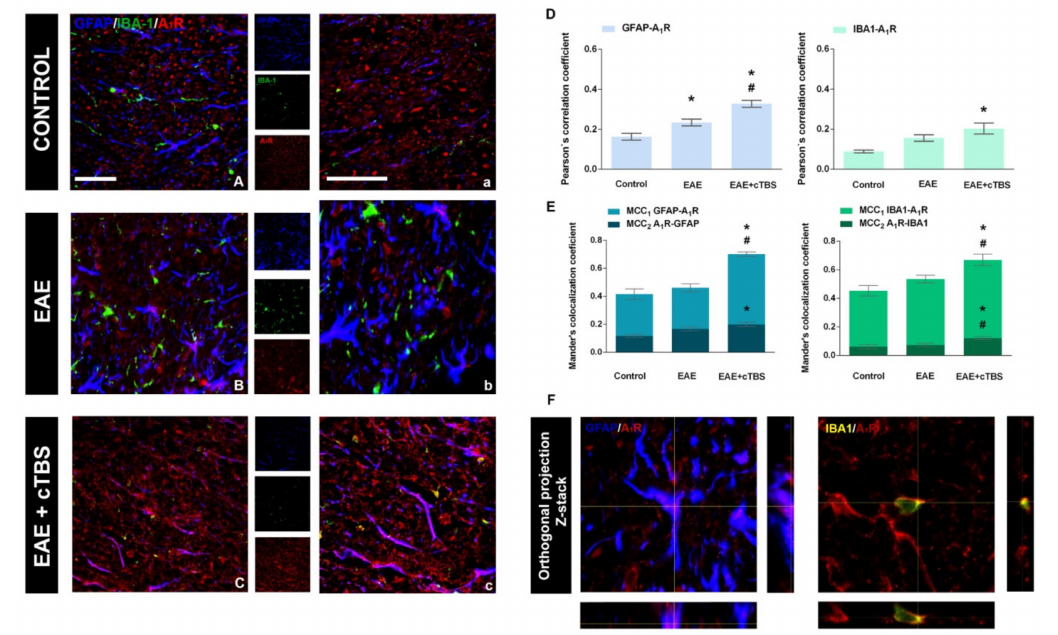
Figure 8. Effects of CTBS treatment on A 1 R expression in lumbar spinal cords of EAE rats. Triple immunofluorescence labeling directed to astrocyte marker GFAP (blue), microglial marker IBA-1 (green), and A 2A R (red). In control sections, moderate staining of A 1 R -ir was observed mostly confined to what appeared to be neuronal elements ( A,a ). In EAE sections, no apparent change in A 1 R -ir was observed compared to control ( B,b ). After CTBS treatment A 1 R -ir was significantly increased on glial cells ( C,c ). Pearson correlation coefficients (PCC) indicating the level of signal overlap between GFAP- ir and A 1 R- ir and IBA-1- ir and A 1 R- ir . Bars show mean PCC ± SEM, from 7–9 images/animal ( D ). Mander’s colocalization coefficient (MCC) indicating level of signal colocalization between GFAP/A 1 R ( MCC 1 , light blue), A 1 R/GFAP (MCC 2 , dark blue), IBA-1/A 1 R (MCC 1 , light green), and A 1 R/IBA1 (MCC 2 , dark green). Bars show mean MCC ± SEM, from 7–9 images/animal ( E ). Orthogonal Z-stack projection of GFAP/A 1 R and IBA-1/A 1 R ( F ). Level of significance: * p < 0.05 or less when compared to control, # p < 0.05 when compared to EAE. Scale bar corresponds to 50 µ m.